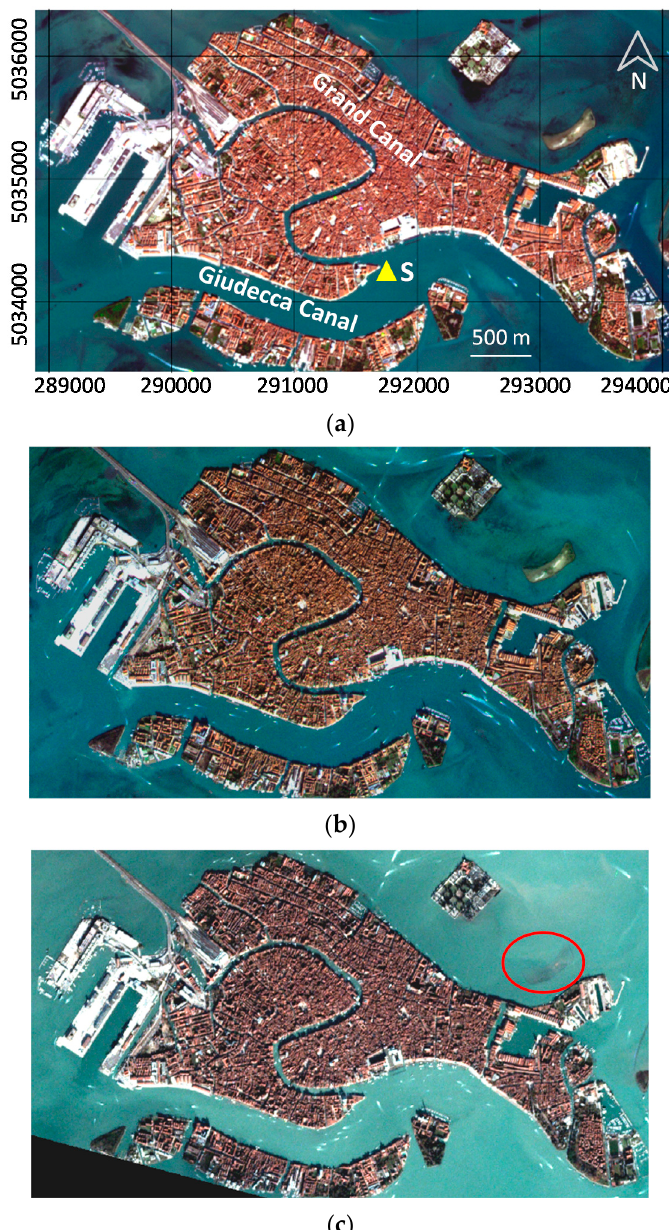
Figure 1. PlanetScope imagery of the study area within the Venice lagoon ( a ) during the COVID-19 lockdown (8 April 2020), ( b ) before the lockdown (23 January 2020), and ( c ) during the extreme flooding period (26 November 2019). The red circle shows a small island which is hardly visible in the flooded condition. The yellow symbol on the first image shows the location of the Punta della Salute station (S).